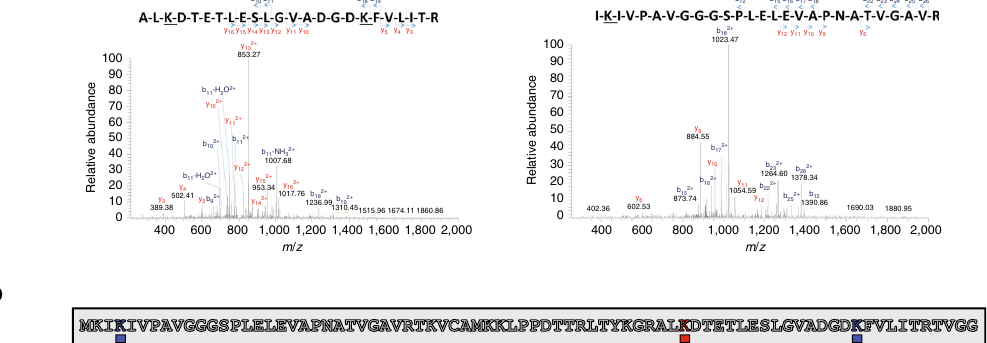
PDB: 2MQJ (C. subterraneum) and 1UBQ (H. sapiens) structural